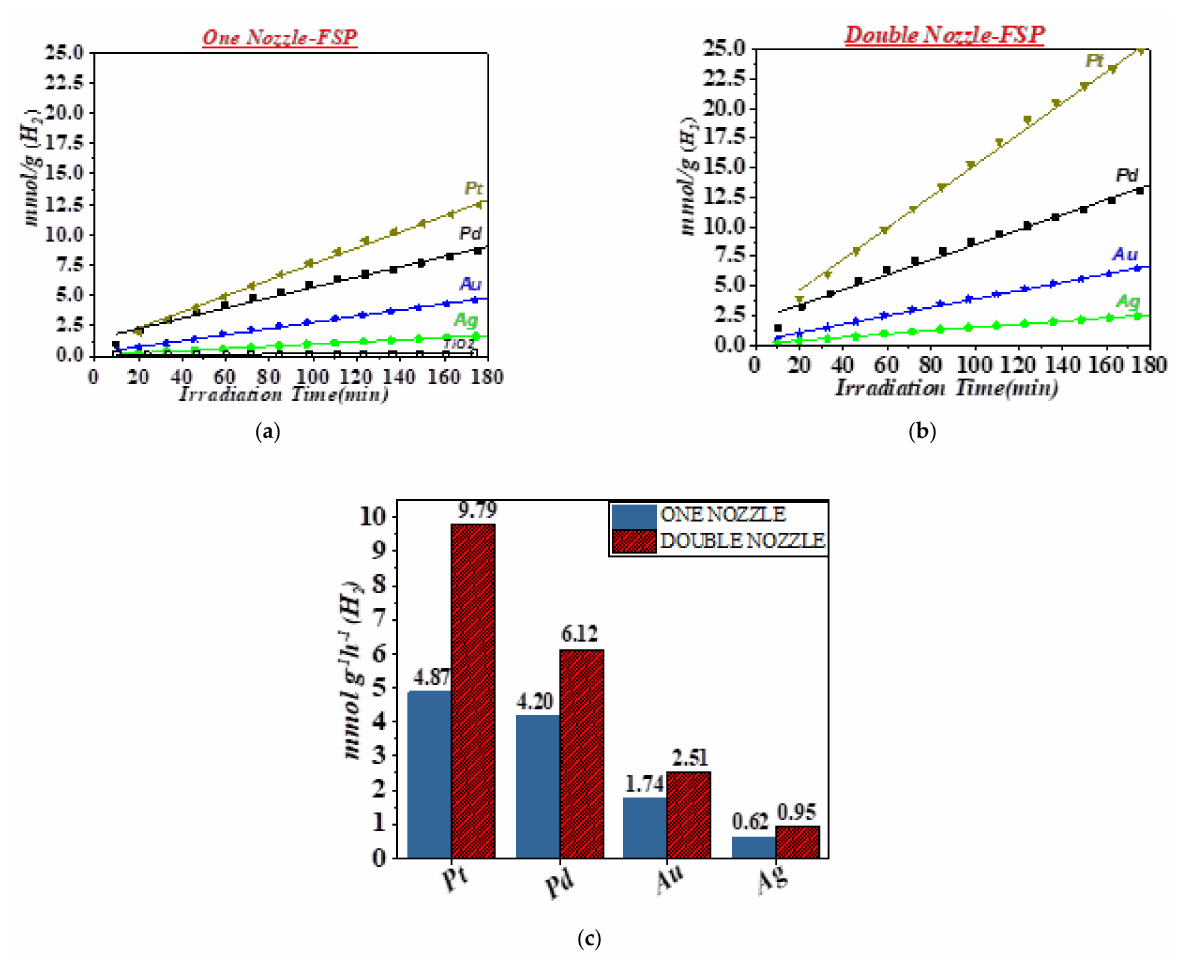
Figure 5. Photocatalytic Hydrogen Production of NM 0 -TiO 2 NPs: ( a ) One nozzle, ( b ) Double Nozzle and ( c ) the rate of produced H 2 (mmol/g · h) is illustrated in column bars for ON and